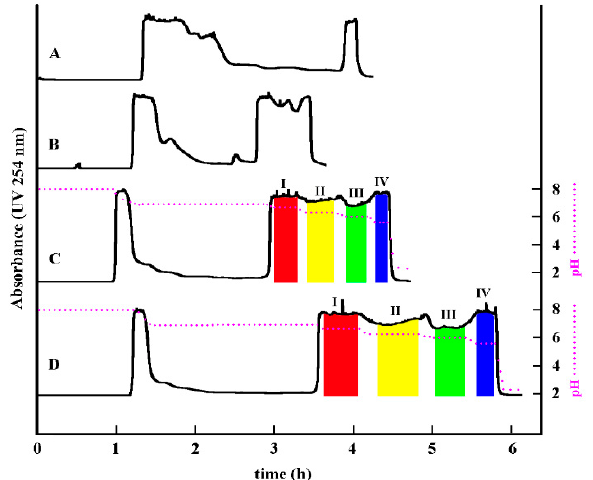
Figure 2. pH-zone-refining counter-current chromatography (pH-ZRCCC) chromatogram of the crude sample of E. yunnanensis . ( a ) hexane–ethyl acetate–methanol–water (3:7:1:9, v/v ), 0.7g of sample, 10 mM triethylamine (TEA) in upper phase, and 10 mM HCl in lower phase; ( b ) hexane–ethyl acetate–